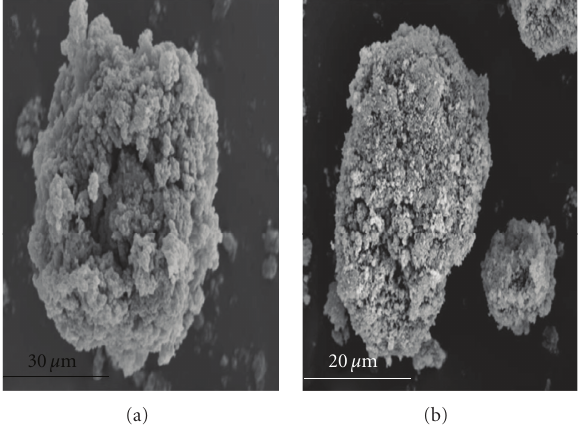
Figure 2: SEM micrographs of PANIG (a) and PANImG (b).